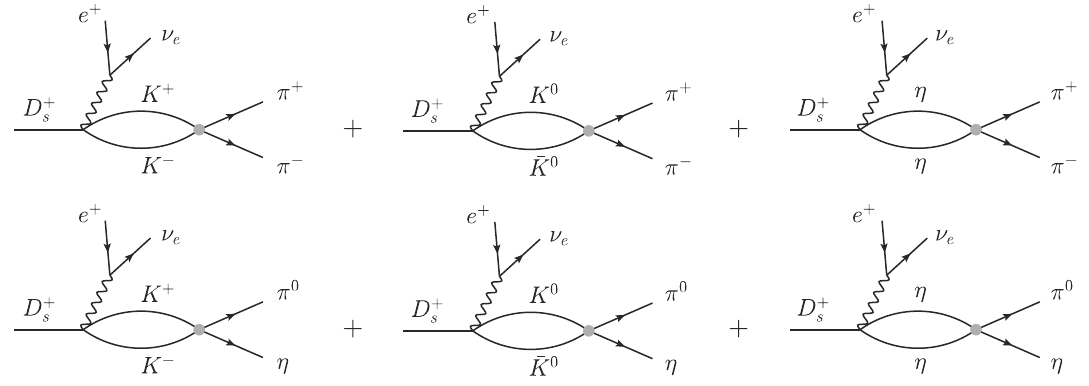
Fig. 2 Final state interaction of the hadron components leading to π + π − or π 0 η in the final state